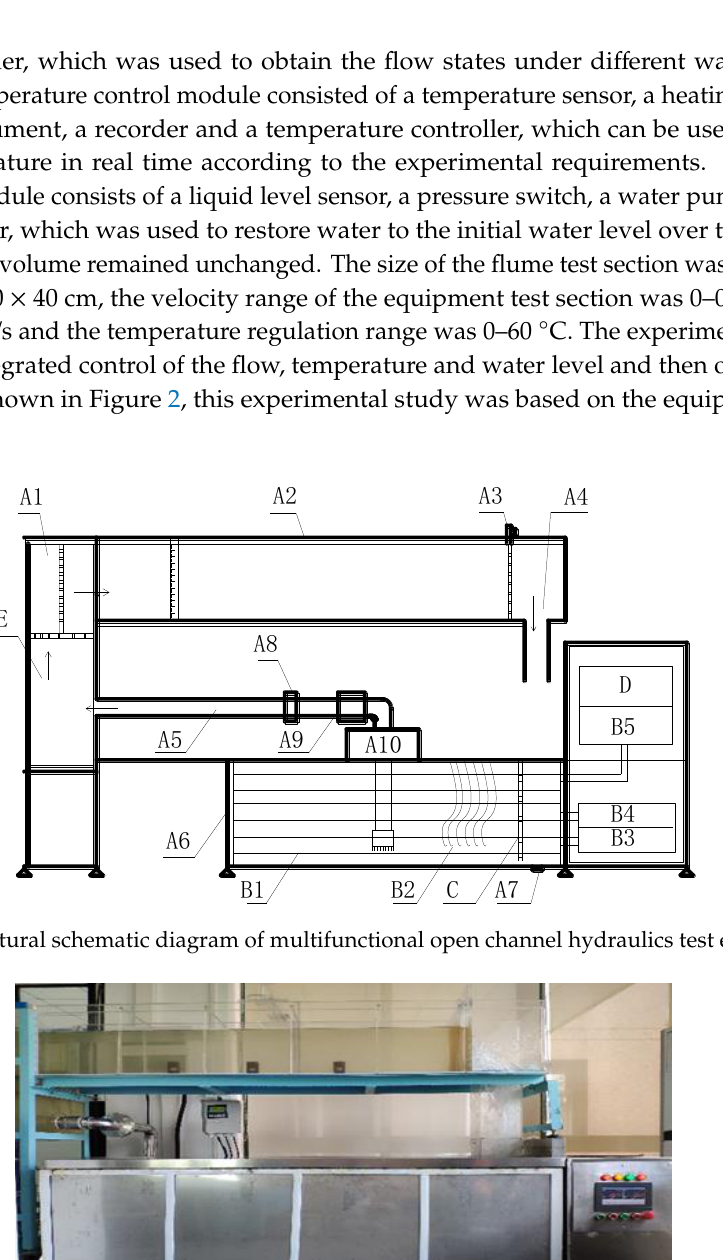
Figure 1. Structural schematic diagram of multifunctional open channel hydraulics test equipment.